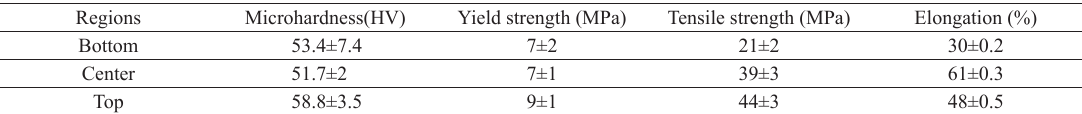
Table 4. Mechanical properties of different regions of directionally solidified pure magnesium Regions Microhardness(HV) Yield strength (MPa) Tensile strength (MPa) Elongation (%) Bottom 53.4±7.4 7±2 21±2 30±0.2 Center 51.7±2 61±0.3